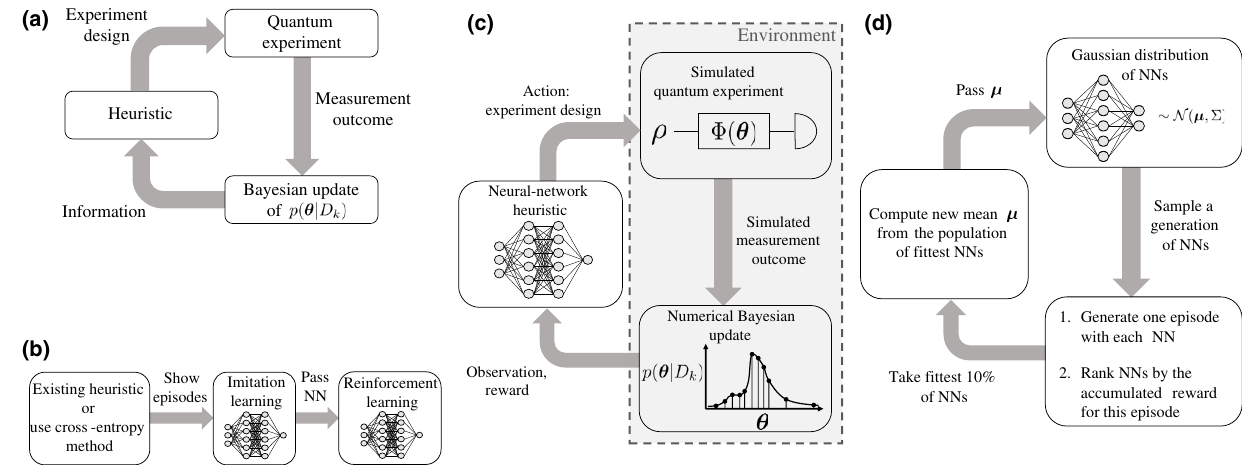
FIG. 1. (a) The setup for adaptive Bayesian quantum estimation. First, prior information [e.g., about the prior p ( θ ) and the available resources] is passed to the heuristic, which returns an experiment design e 1 . From the quantum experiment, we obtain a measurement outcome d 1 , which is used to numerically compute the Bayesian update of p ( θ ) . Then, (updated) information is again passed to the heuristic and this cycle is repeated in the same manner until some exit condition is fulfilled. (b) The training procedure for the NNs. First, the NN learns to imitate the behavior of a known heuristic (which may have been found by the cross-entropy method). Then we use this NN as a starting point for RL. (c) The RL setup for generating training data. An agent (depicted as a NN) interacts with a RL environment. The RL environment defines the estimation problem. It consists of a simulated quantum experiment [depicted with initial state ρ and parameter-dependent quantum channel (cid:3)( θ ) ] and a numerical Bayesian update. It also stores information about available resources for experiment design. (d) The evolutionary principle of a simple cross-entropy method. NNs are treated as vectors of parameters sampled from a Gaussian distribution N ( μ , (cid:4)) with constant covariance. At the beginning, the NNs are initialized